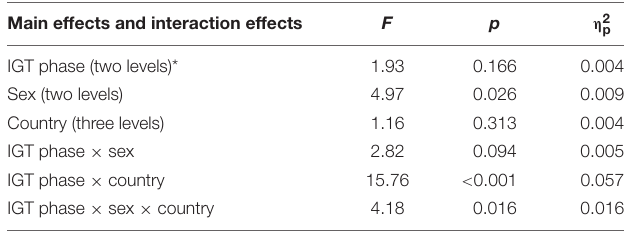
TABLE 2 | Summary of the mixed ANOVA including the factors IGT phase (within), sex (between), and country (between) on IGT net score. Main effects and interaction effects